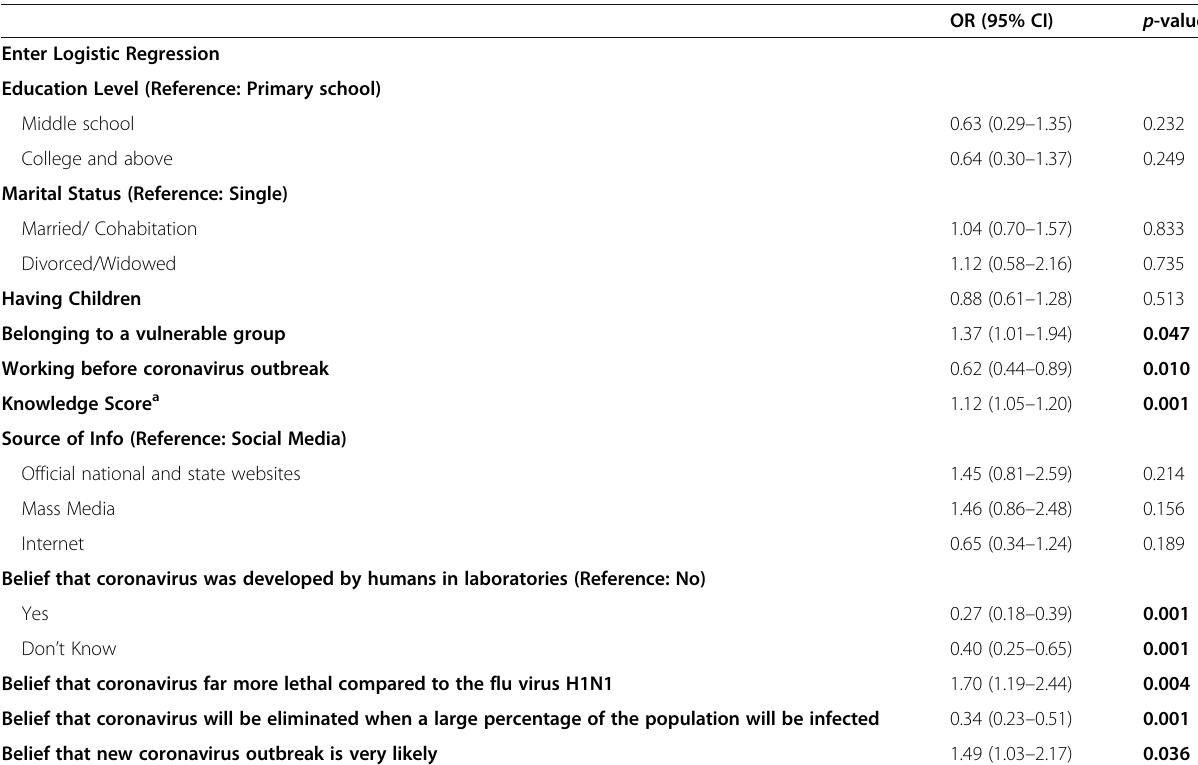
Table 4 Impact of factors on participant ’ s intension to vaccinate against Coronavirus